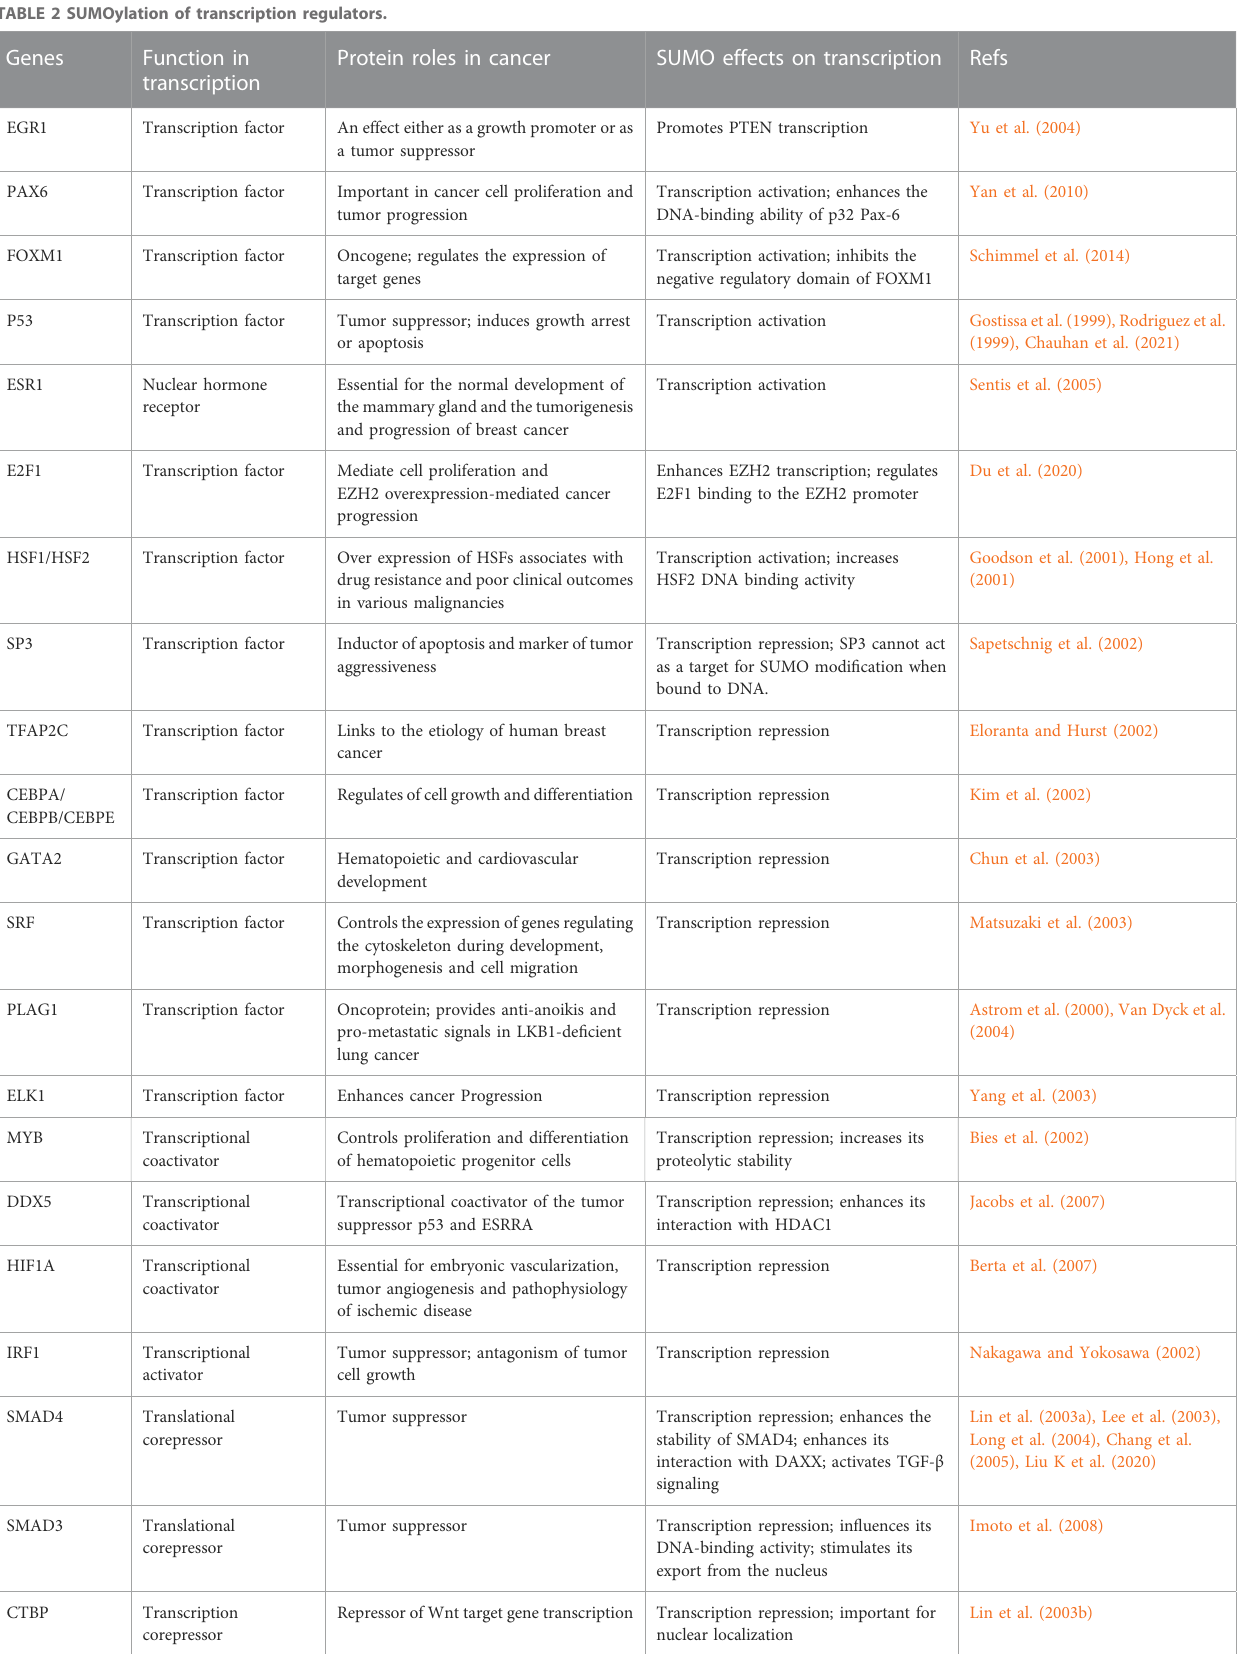
TABLE 2 SUMOylation of transcription